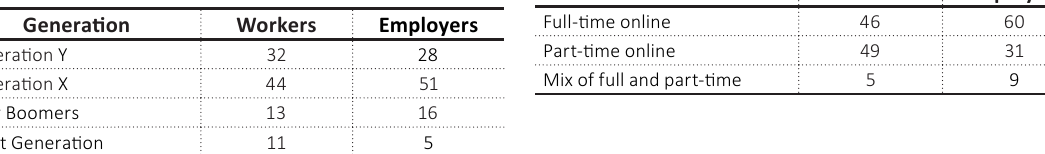
Table 3. Interviewed respondents by generation, %